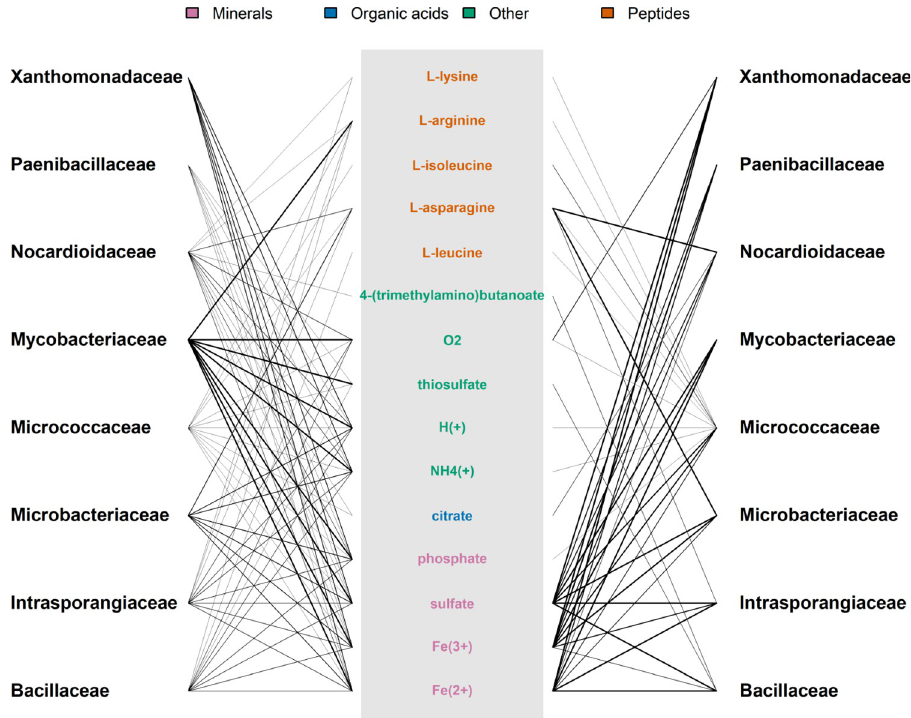
Fig 5. Putative metabolic interactions between the bacterial families in the Schlaeppi community. The sets of imported and secreted metabolites that were determined for each member during conditional gap-filling and grouped into corresponding bacterial families. On the left-hand side, metabolite export is shown, which does not require a reduction of growth greater than 10%. The common pool of exchanged metabolites is shown in the center, which were classified using the KEGG BRITE br08001 with manual refinement. On the right-hand side, import reactions are shown, which were introduced during the gap-filling procedure. Line widths represent the number of community members per import/export of a metabolite, scaled by the abundance of the respective